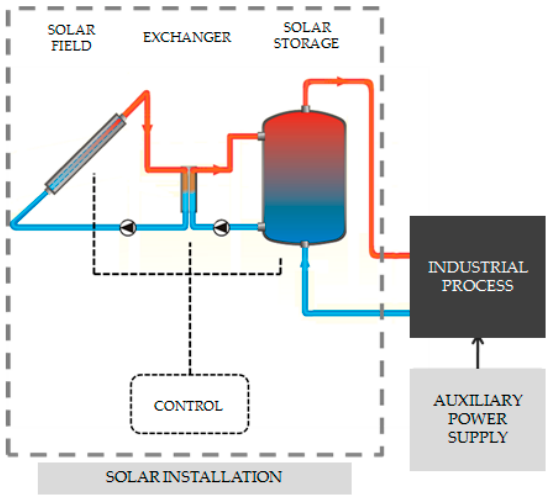
Figure 7. Configuration of the analyzed plant.